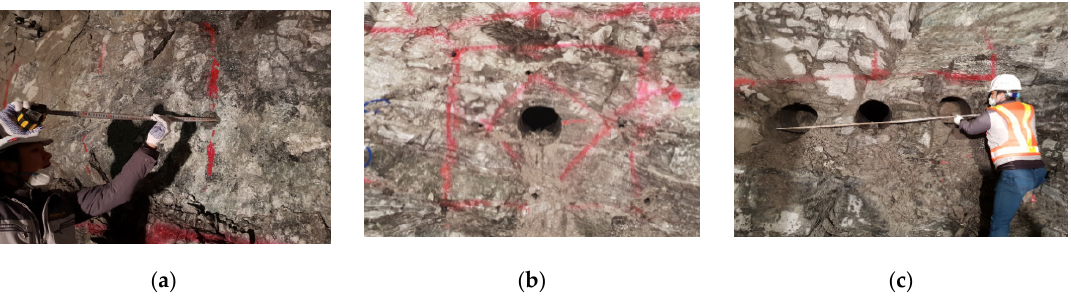
Figure 8. Site images of cut sections for ( a ) general blasting, ( b ) CB-2, and ( c ) CB-4.